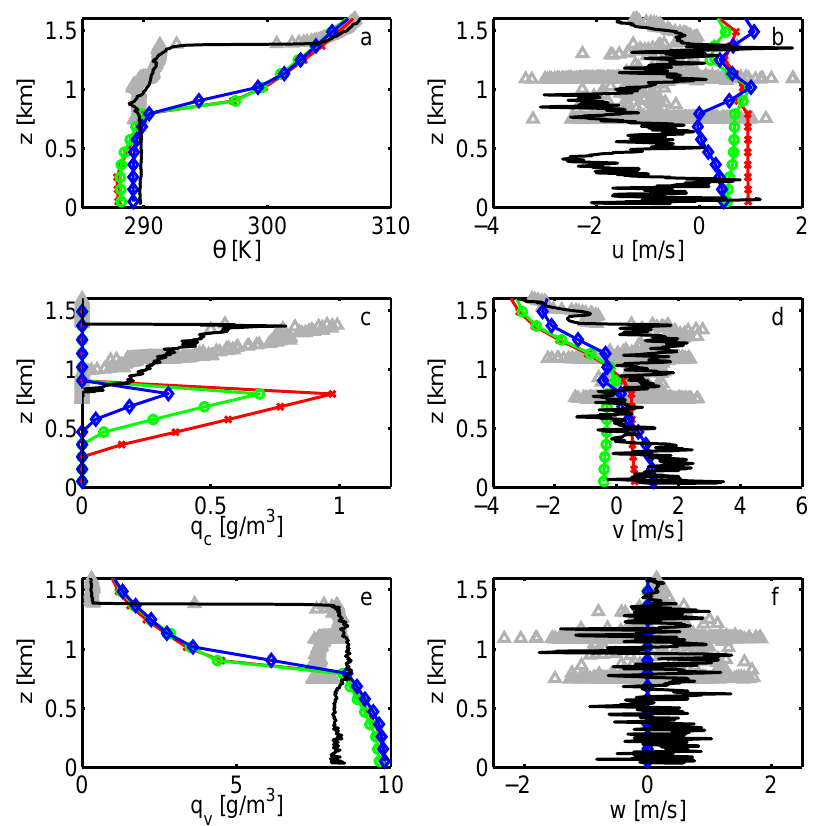
Fig. 4. Model sensitivity to the microphysics parameterizations for the run with 81 vertical levels and for profile 3; blue – REF, green – SM1,